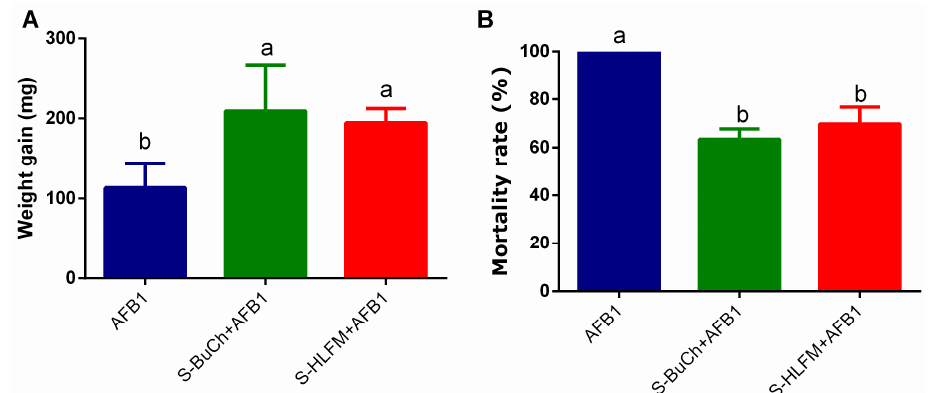
Figure 2. Effects of volatile smelling of herbicides on AFB1 resistance of H. armigera . Weight gain ( A ) and Mortality rates ( B ) of H. armigera caterpillars reared on Aflatoxin B1 (AFB1)-supplemented diet after pre-exposed of volatile herbicides. Newly molted third-instar caterpillars were fed on control